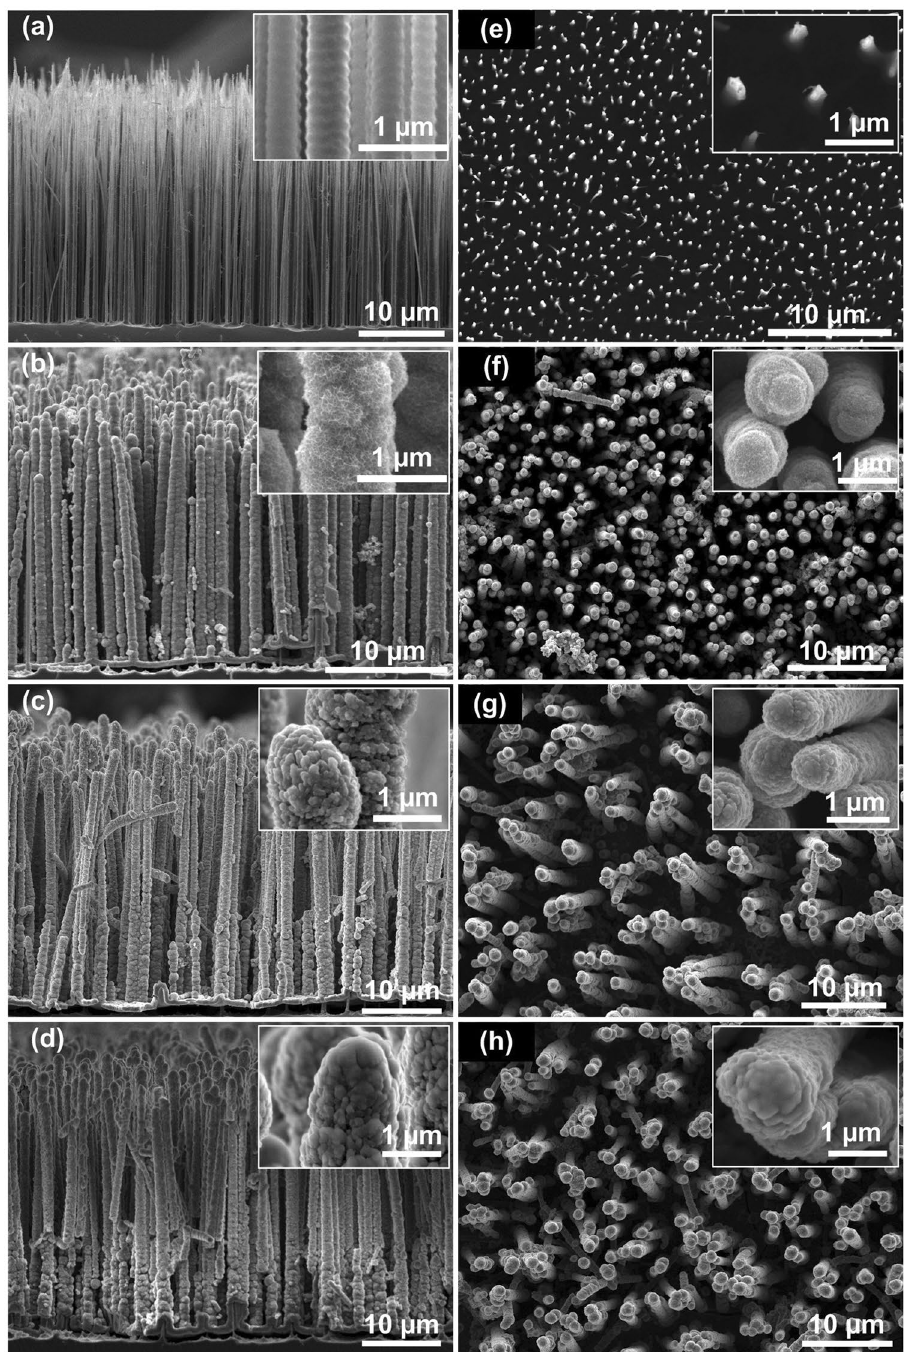
Figure 2. Cross-sectional and top-view SEM images of ( a and e ) Si-W arrays, ( b and f ) Si-W/MnO 2 rods, ( c and g ) Si-W/MnO 2 /Al nanoenergetic arrays, and ( d and h ) Si-W/MnO 2 /Al/fluorocarbon arrays. Insets are respective magnified